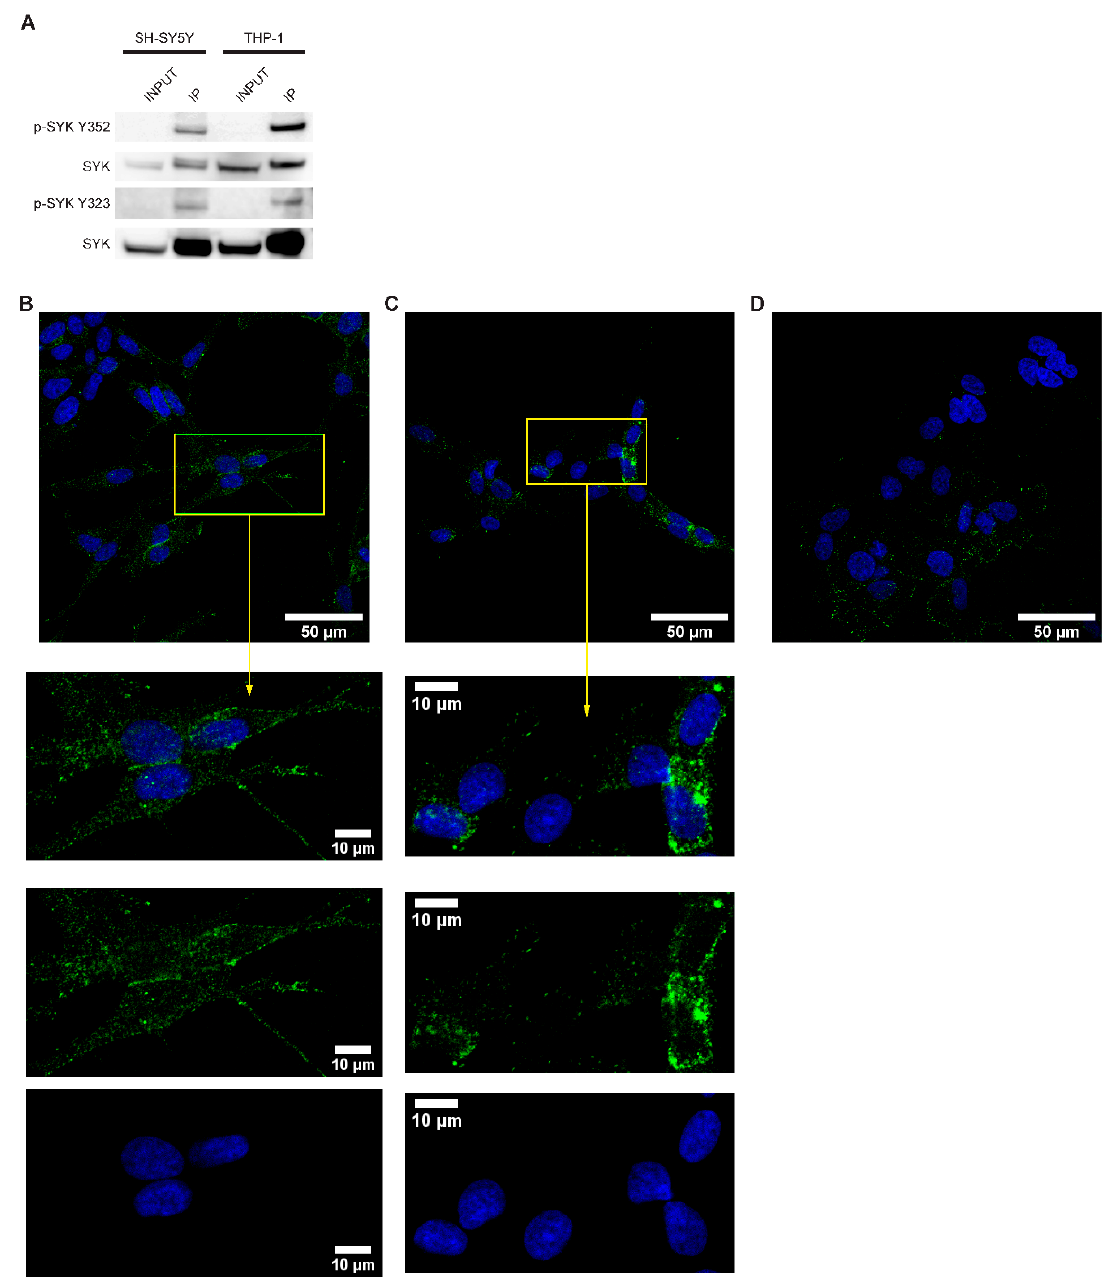
Figure 3. SYK is phosphorylated in neuroblastoma cell lines. ( A ) Immunoprecipitation with a SYK specific antibody was performed followed by western blot using antibodies against the SYK Tyr352 and Tyr323 phosphorylation residues. THP-1 cells were used as a positive control. Immunofluorescence labeling of p-SYK (Tyr525/526) in SH-SY5Y ( B ) and LAN-6 cells ( C ). SK-N-BE(2) cells ( D ) served as a negative control. The nuclei (blue) were stained with Hoechst 33342.